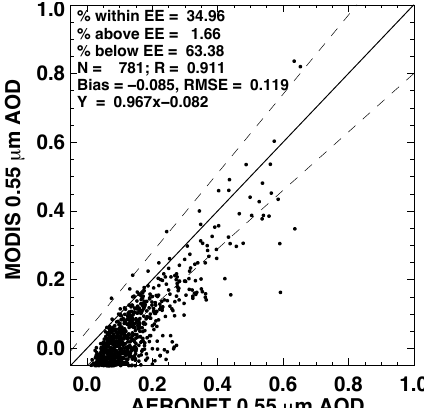
Figure 3. Comparison of actual AERONET measurements and op- erational Aqua MODIS Collection 6 aerosol product for Brazil sites Campo_Grande_SONDA, Sao_Paulo, and CUIABA-MIRANDA in the general vicinity of MCARS